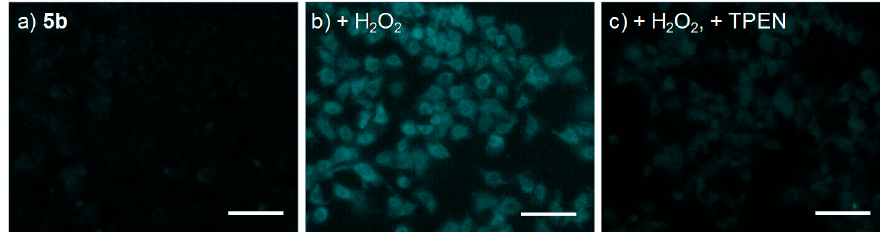
Figure 7. Fluorescence images of endogenous Zn 2 + in A549 cells: ( a ) Fluorescence image of cells with 5b (100 μ M); ( b ) fluorescence image incubated with 5b (100 μ M) after incubation with H 2 O 2 (200 μ M) for 24 h; ( c ) fluorescence image of ( b ) after treatment with TPEN (100 μ M). Scale bars = 300 μ m.